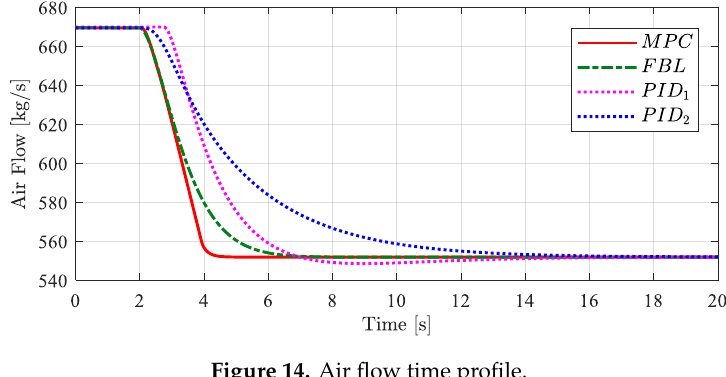
Figure 14. Air flow time profile.